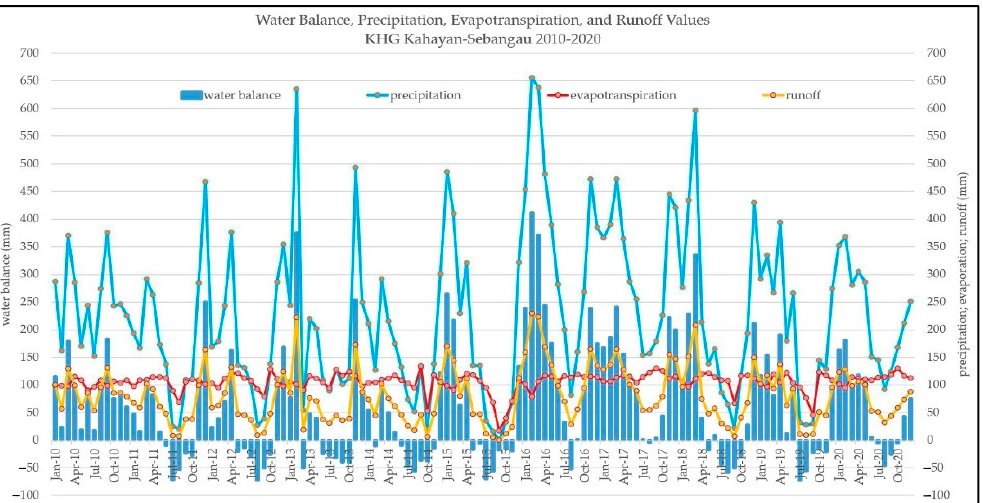
Figure 6. Conditions of rainfall, evapotranspiration, runoff, and water balance in Kahayan–Sebangau PHU in 2010–2020. (data source: TerraClimate using Google Earth Engine; processed by the authors).